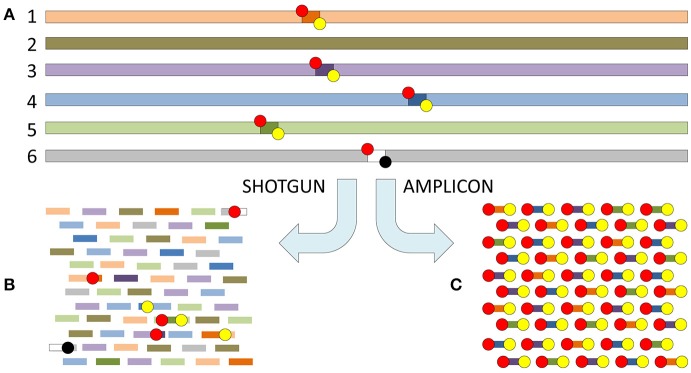
The difference between shotgun metagenomics and amplicon based metataxonomic sequencing. (A) Six different genomes (1–6) shown in different colors with five of the six (1 and 3–6) containing a shared genomic region. The shared genomic region in all five has a conserved motif on the left side (red circle = forward primer binding site), but one of them has a significant change in the conserved motif on the right side (yellow circle = reverse primer binding site) resulting in primer mismatch (black circle). (B) The sequenced fragments with shotgun metagenomics are random motifs from the six different genomes, and only one of the conserved (primer binding) motifs will exceptionally be included. (C) The sequenced fragments with amplicon sequencing are only those delimited both by a conserved left and right motif (red and yellow circles). The difference in mean coverage per nucleotide is significant. Assuming that each genome has the same length (e.g., 108 bp) and is present in equal concentration in the original sample, a read length of 200 bp, and an invariant length of the shared genomic region delimited by the primer sites of 250 bp, the mean coverage per nucleotide of the targets will be: (B)
R × L/N × G = 106 × 200 bp/6 × 108 bp = 1/3 where R = number of reads, L = read length, N = number of genomes and G = genome size. (C)
R × L/A × D = 106 × 200 bp/4 × 250 bp = 2 × 105 where R and L are the same as for B, while A = number of genomes flanked both by conserved forward and reverse primer sites, and D = the length of the shared genomic region delimited by the primer sites. In this example C is 6 × 105 times more sensitive than B. Shotgun reads may be analyzed applying all bioinformatics approaches (assembly, mapping and k-mer analysis, alignment dependent and alignment free; cf. Figures 2, 3). Amplicon reads are usually analyzed by mapping, clustering and phylogenetic approaches, while assembly is only exceptionally applied.